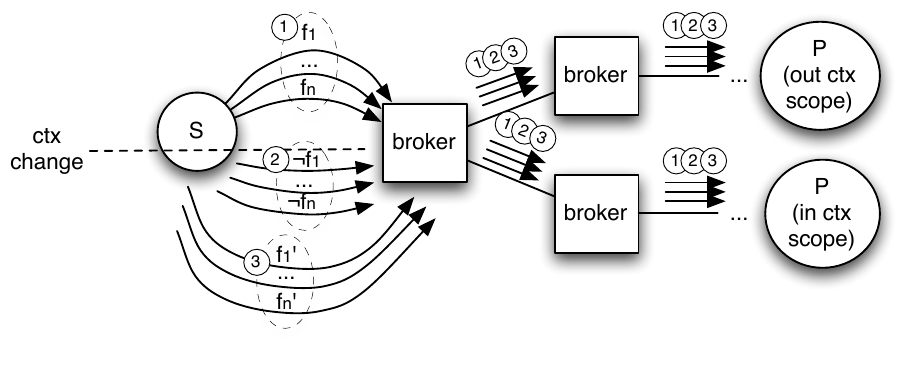
Figure 1. Exchange of messages with implicit context